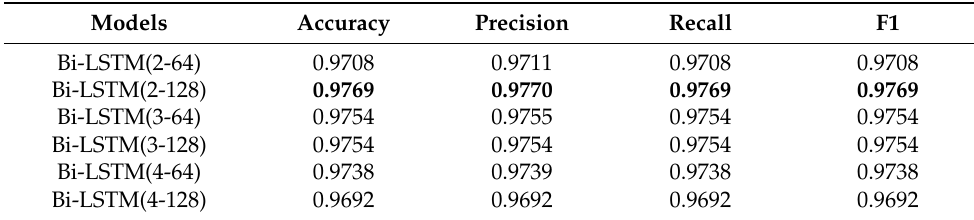
Table 5. Different parameters of Bi-LSTM.